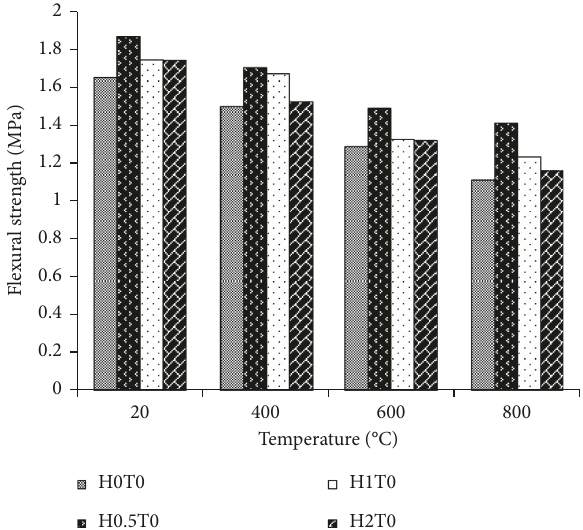
Figure 6: Flexural strength results for carbon fiber-reinforced lightweight concrete containing 20% silica fume.